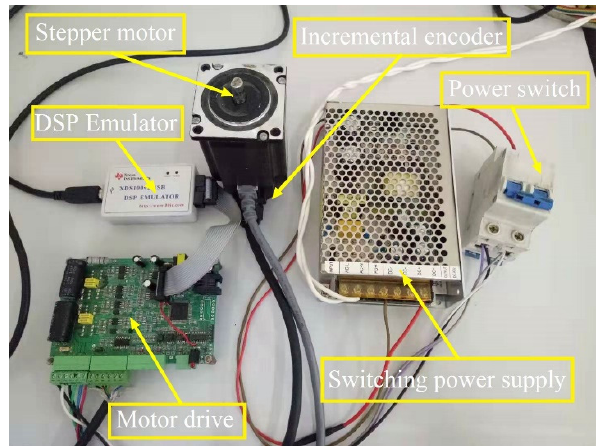
( b ) Figure 9. Currents of ( a ) winding A and ( b ) winding B for N = 1 and N = 8. 4. Implementation and Experimental Results The experimental setup consists of a two-phase bipolar hybrid stepper motor, an incremental encoder which has 2500 lines 10,000 pulses/rev, attached to the motor, and is used for measuring the rotor position and speed, a DC switching power supply, and a stepper motor drive for real-time shown in Figure 10. The parameters of the stepper motor and the drive are shown in Table 2. The drive implements the proposed sensorless speed control scheme and has been successfully applied